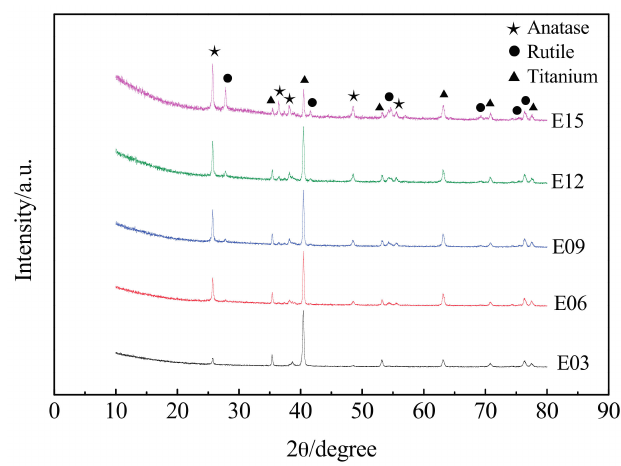
Figure 4. XRD of MAO coating at different oxidation times. E03: 3 min; E06: 6 min; E09: 9 min; E12: 12 min; and E15: 15 min.